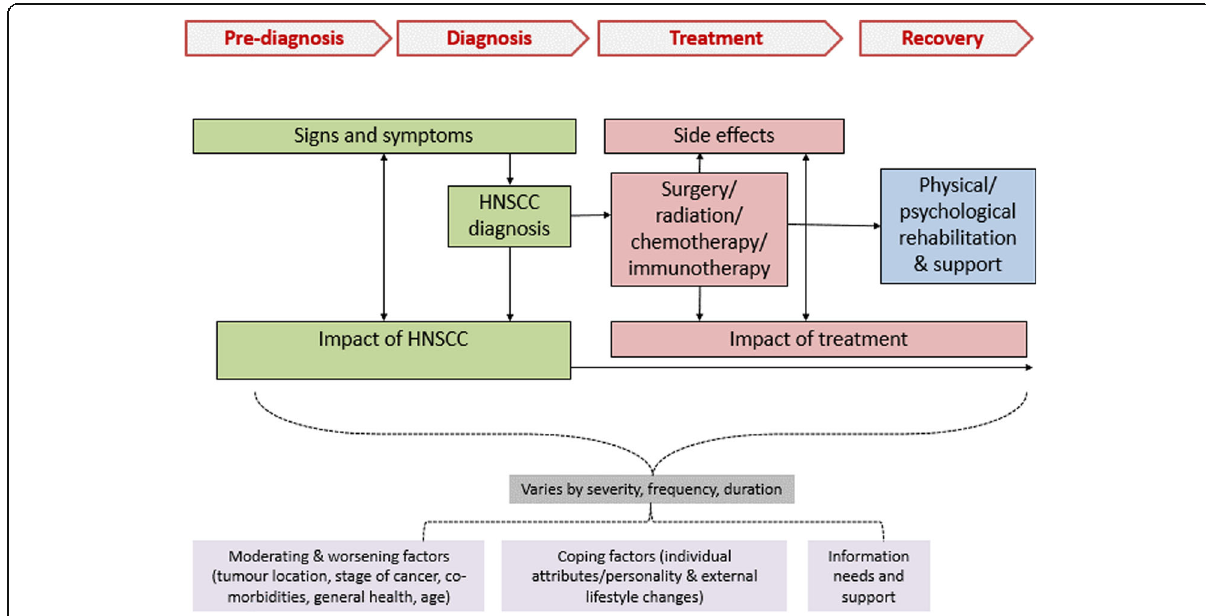
Fig. 1 Patients road map in HNSCC. Abbreviations: HNSCC, head and neck squamous cell carcinoma